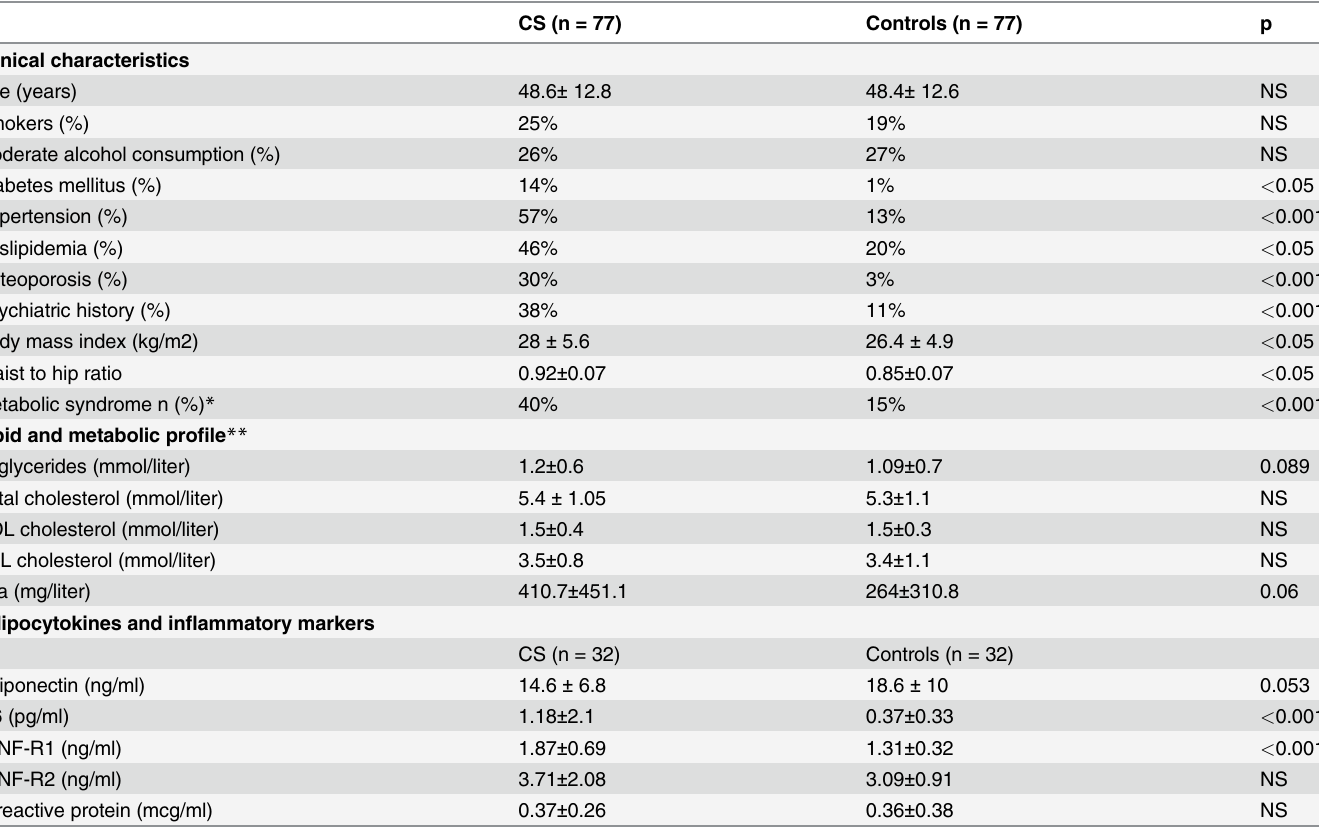
Table 1. Clinical and biochemical characteristics of patients with Cushing ’ s syndrome (CS) and controls. CS (n = 77) Controls (n = 77) p Clinical